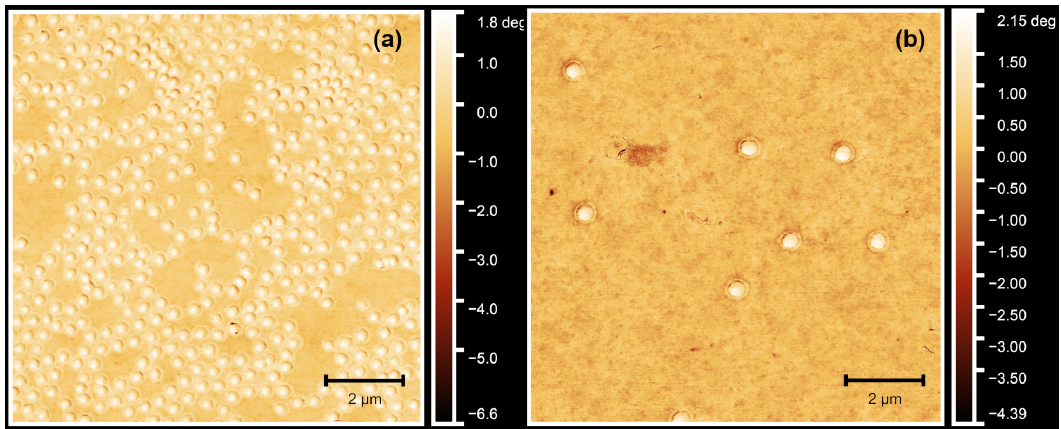
Figure 1. Atomic force microscopy (AFM) phase images of the PNIPAM– co –AAc core microgels ( a ) and, as a typical example, the core-shell microgel sample PNN50/PMAM50 ( b ). In ( b ), the corona formed in the second precipitation polymerization step can be clearly identified. All measurements were performed in the dry